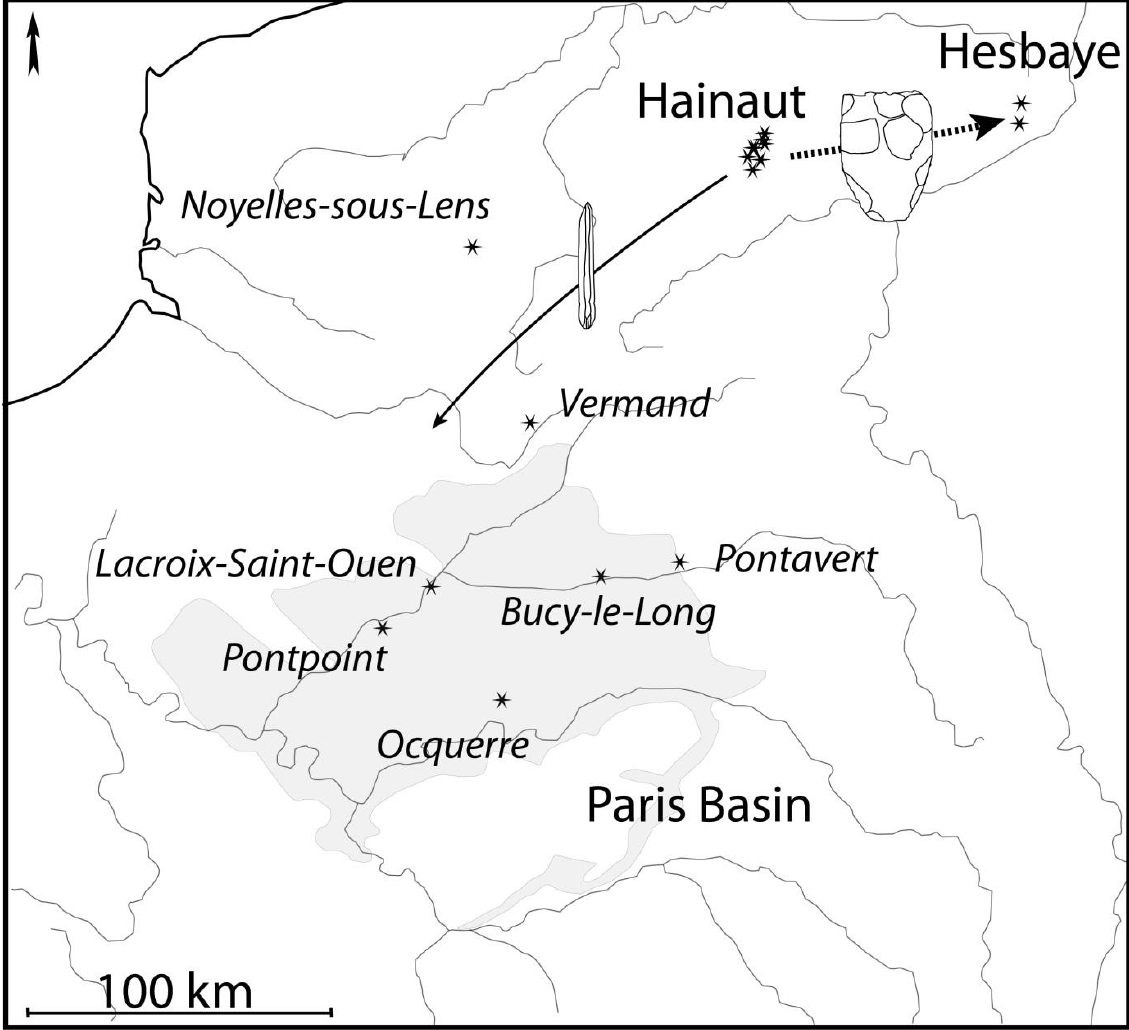
Figure 11. Schematic map of the circulation of Ghlin flint: sites concerned and opposition on the circulation